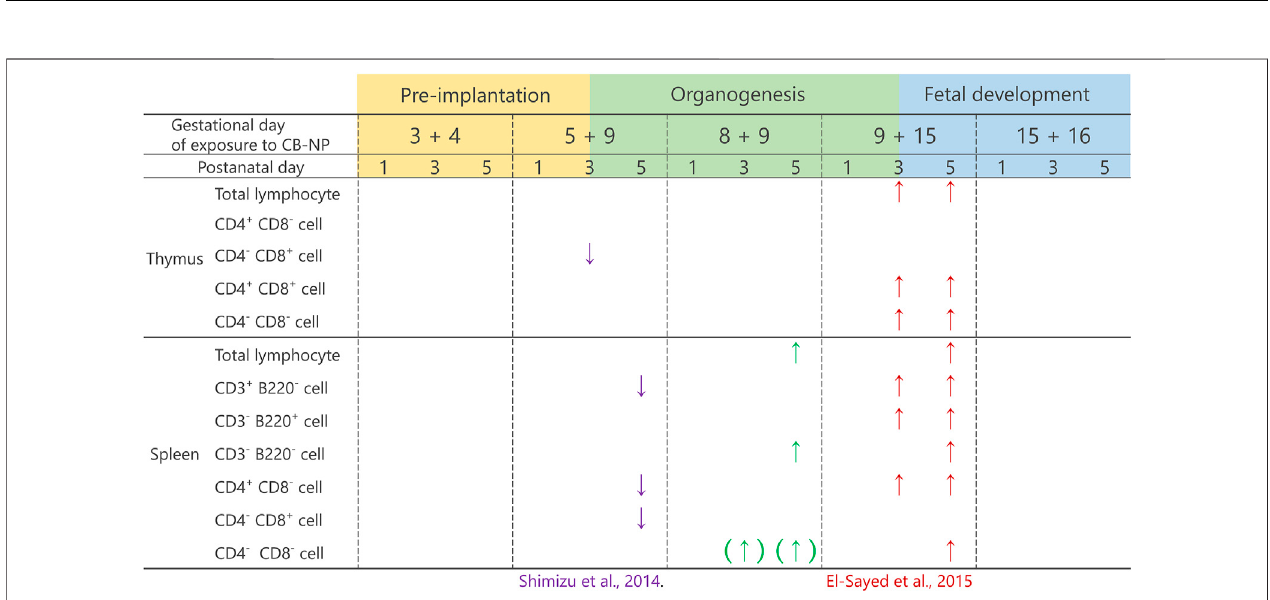
FIGURE 7 | Summary of the effects of maternal exposure to carbon black nanoparticle on lymphoid tissues. The present study and the previous studies have shown that the effects of maternal CB-NP exposure on the population of lymphocytes in the thymus and spleen were different depending on the gestational periods of theexposure. Theeffectsweregreaterforexposuresthatincludetheorganogenesisperiod.Theevidencesuggeststhatlong-termexposureacrossmultiplegestational periodsincluding theorganogenesisperiod may cause serious effects on thedevelopmentofimmunetissues comparedwith acute exposure.The arrows indicate a signi fi cant increase or decrease in the cell number. The arrows with brackets indicate a tendency of the increase or decrease in the cell number.